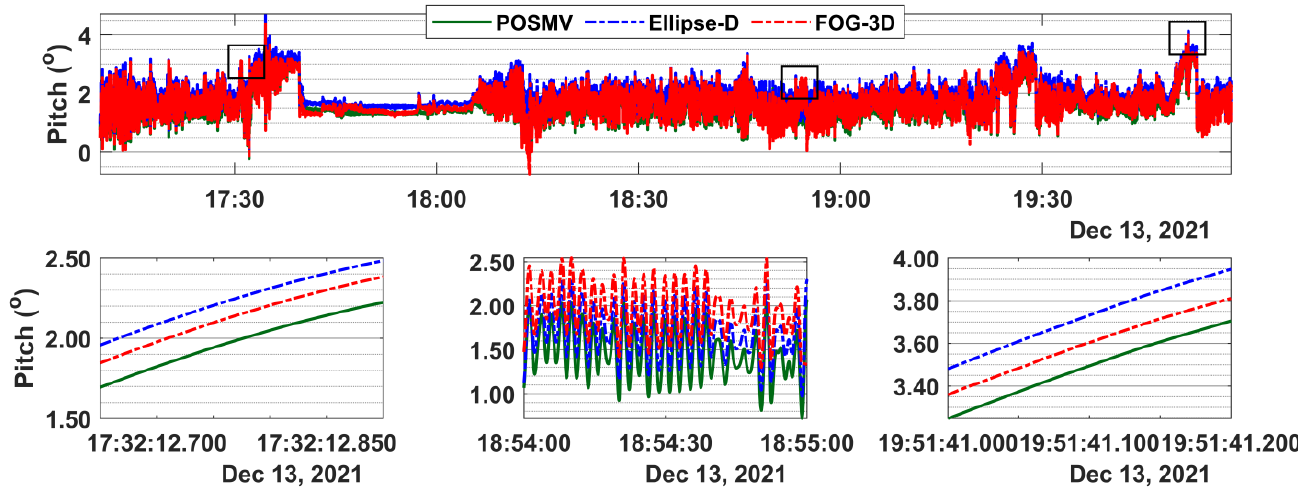
Figure 6. Top panel: pitch time series for POSMV, Ellipse-D, and FOG-3D. Bottom panel: shows 0.1-s, 30-s, and 0.1-s snippets at the time series’ beginning, middle, and end.